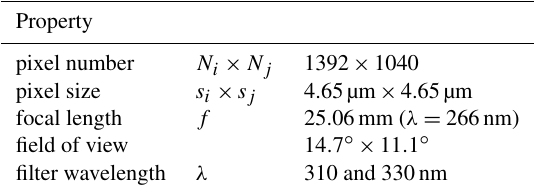
Table 1. Summary of SO 2 camera properties.